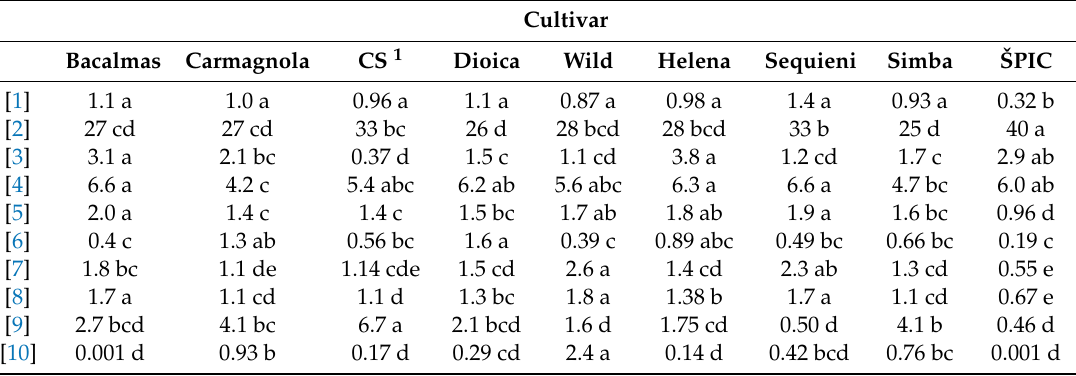
Table 2. Mean concentration (%) of isocaryophyllene ( γ -caryophyllene) [1], β -caryophyllene [2], α -(E)-bergamotene [3], caryophyllene oxide [4], humulene epoxide 2 [5], selina-6-en-4-ol [6], caryophylla-4(12),8(13)-dien-5 β -ol [7], β -bisabolol [8], α -bisabolol [9], and δ 9-tetrahydrocannabinol (dronabinol) [10] obtained from the 9